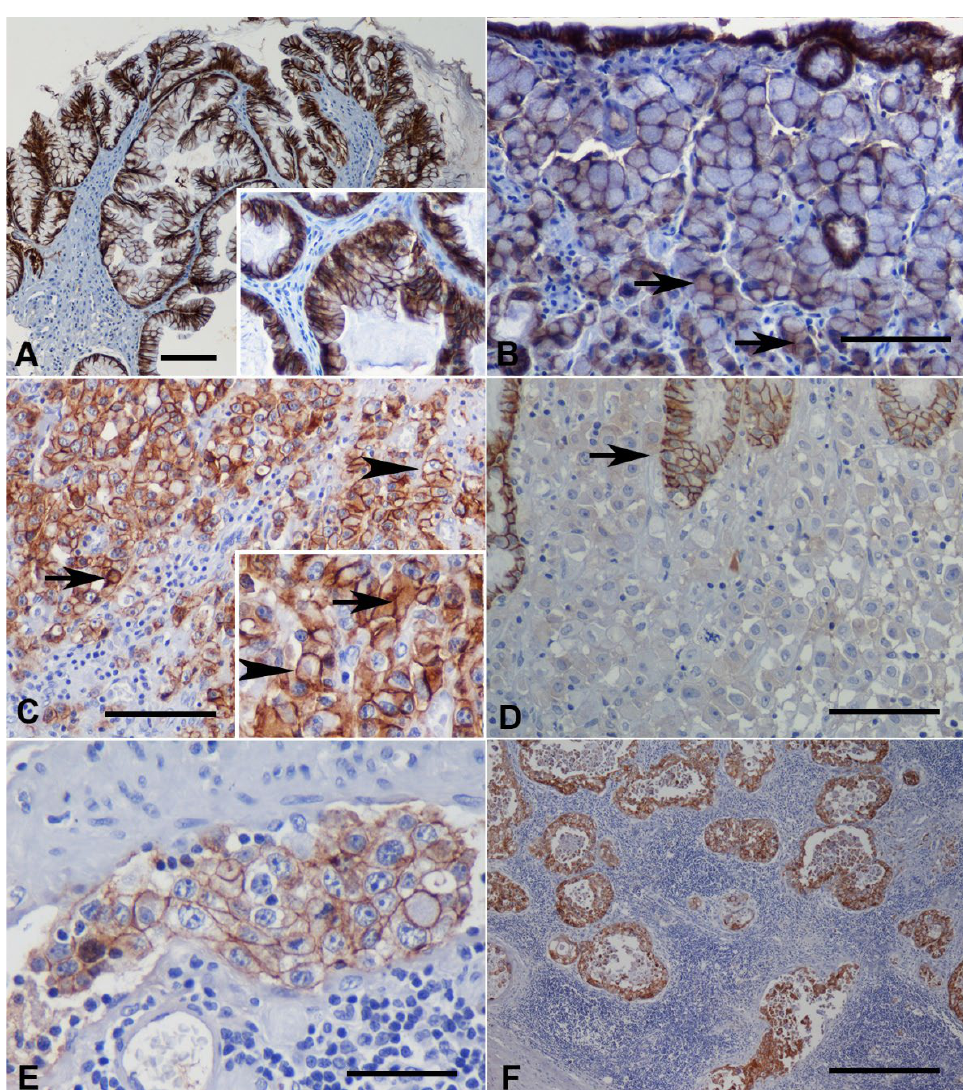
Figure 3. Gastric carcinomas. Immunohistochemistry for E-cad counterstained with Mayer ´ s hema- toxylin. ( A ) Tubular carcinoma (WHO) and intestinal type carcinoma (Lauren) displaying E-cad immunoreactivity at the lateral cellular membrane (polarized pattern, score 3). (bar = 100 μm). Inset shows a higher magnification of the normal staining pattern (400×). ( B ) Signet ring cell carcinoma (WHO) and diffuse type carcinoma (Lauren) showing E-cad membranous staining, localized in the whole cell membrane (non-polarized pattern, score 3), in the majority of neoplastic cells. Cytoplas- mic staining can be seen occasionally (arrow) (bar = 100 μm). ( C ) Heterogenous staining (score 2) with diffuse cytoplasmic staining (arrow) combined with membranous staining (arrowhead) in a tubular carcinoma (WHO) and intestinal type carcinoma (Lauren) (bar = 100 μm). Inset shows a higher magnification of the cytoplasmic and membranous staining (400×). ( D ) Absence of staining (score 0) with completely loss of staining in the tumor area, while in the adjacent non-neoplastic mucosa membranous staining was preserved (arrow) (bar = 100 μm). ( E ) Neoplastic emboli from a tubular carcinoma (WHO) and intestinal type carcinoma (Lauren) displaying normal pattern of im- munoreactivity (bar = 50 μm). ( F ) Lymph node metastasis exhibiting heterogeneous staining (score 2), similar to that of primary tumor (tubular carcinoma (WHO) and intestinal type carcinoma (Lau- ren)) (bar = 500 μm).